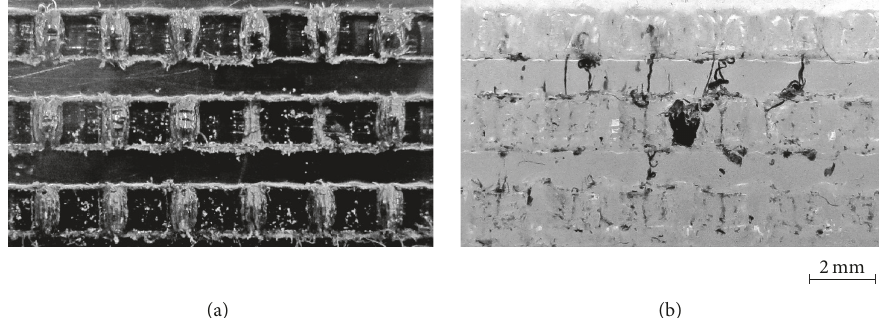
Figure11:Adhesivefracturebehavioroftestspecimen,capturedbyphotographyaftermechanicaltest. (a)SectionofjoiningpartnerA(PA66) after shear test. (b) Section of joining partner B (HDPE) after shear test.